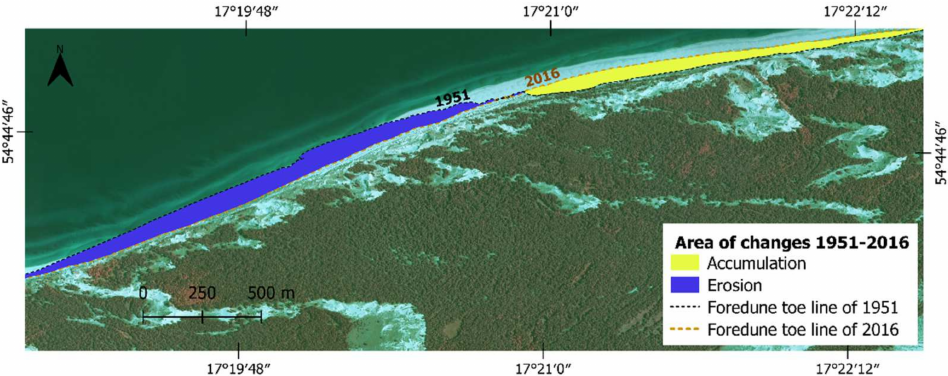
Figure 5. The vectors of intersecting foredune toe lines from 1951 and 2016 create polygons (closed areas), which were used to calculate the size of the accumulated and eroded areas. The base map/orthophotomap dated 2010.